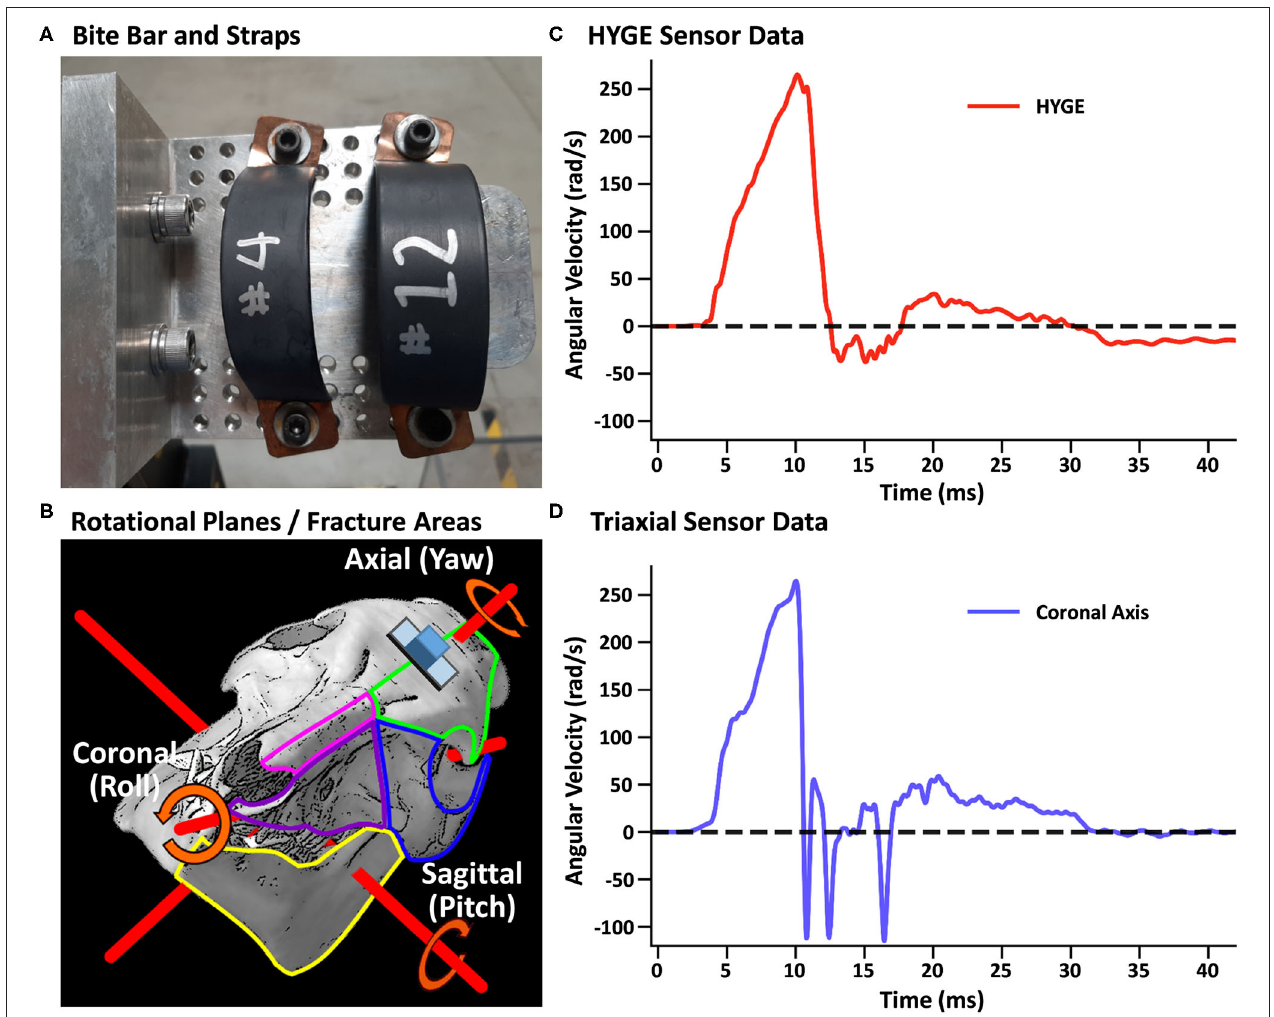
FIGURE 1 | (A) Restraint device (bite bar and straps) used in the initial and replication cohorts. (B) Representative pig skull depicting the three principal axes (red rods) as well as the placement of the skull sensor (blue cube) and plate (gray rectangle). The skull is rotated 44 ◦ along the coronal axis to match the initial starting point of the head when mounted on the restraint device in experiments 1 and 2. The skull also depicts regions of observed fractures (green outline: frontal bone; blue: orbital bone; pink: nasal bone; purple: maxilla; yellow: mandible) recorded in Table 3 . (B) was adapted from University of Texas High-Resolution X-ray CT Facility (NSF IIS-0208675; http://digimorph.org/specimens/Sus_scrofa/skull/). Angular velocity traces (radians/second, rad/s) are shown for the HYGE machine sensor [ (C) , red trace] and the triaxial sensor [ (D) , coronal axis = blue trance] when affixed directly onto the bite bar. All angular velocity traces are windowed to include 4ms of data prior to the identified rise